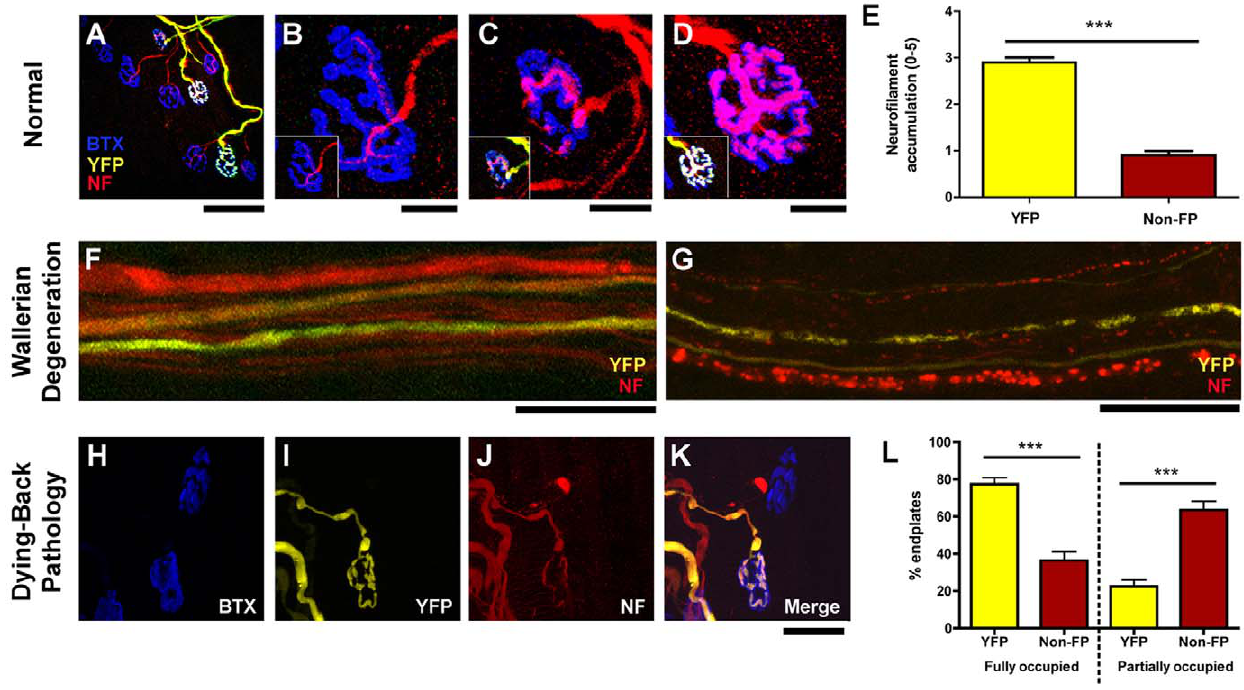
Figure 2. YFP expression in motor neurons subtly disrupts normal neuronal morphology and alters responses to dying-back pathology but not Wallerian degeneration. A–D – Representative confocal micrographs of NMJs in the levator auris longus muscle from a YFP- H mouse labelled for neurofilaments (NF: red) and postsynaptic motor endplates (BTX: blue). Note that all motor endplates were innervated, but only a small proportion of motor axons were YFP-positive in these mice (A). Panels B–D show high power micrographs of NMJs identified in panel A. Note abnormal accumulations of NF only in the motor nerve terminals of YFP-positive NMJs (B=NF accumulation score of 0, C=3, D=5). E – Bar chart (mean 6 s.e.m.) showing quantification of NF accumulation in motor nerve terminals from YFP-H mice (0=no accumulation; 5=large